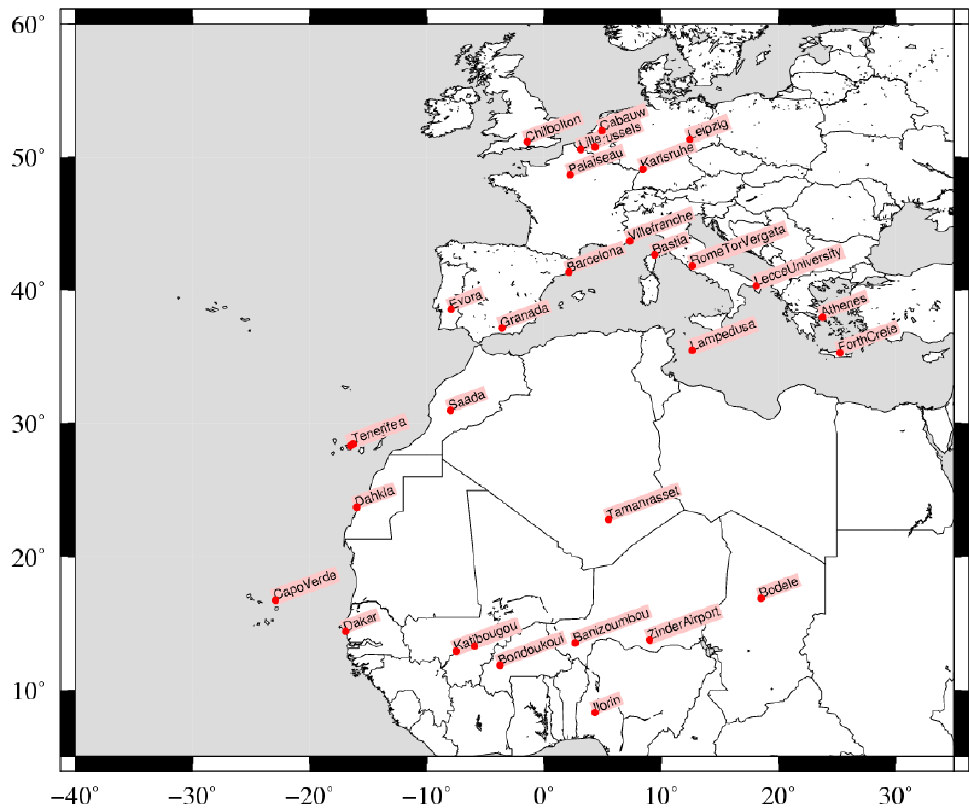
Figure A1. Maps of AERONET sites for the AOD measurements.